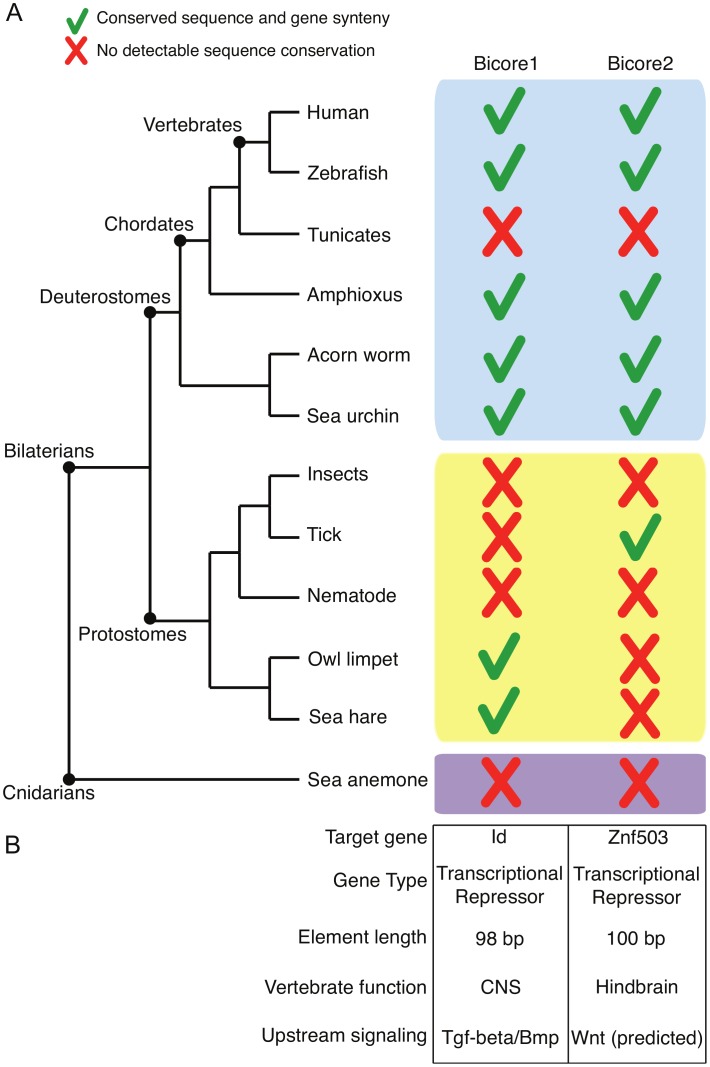
Ancient enhancers.(A) Pattern of conservation of Bicores across the metazoan tree. Green checks denote conservation of sequence and gene synteny. Red crosses denote no detectable sequence conservation. (B) Characteristics of Bicores. CNS – central nervous system.